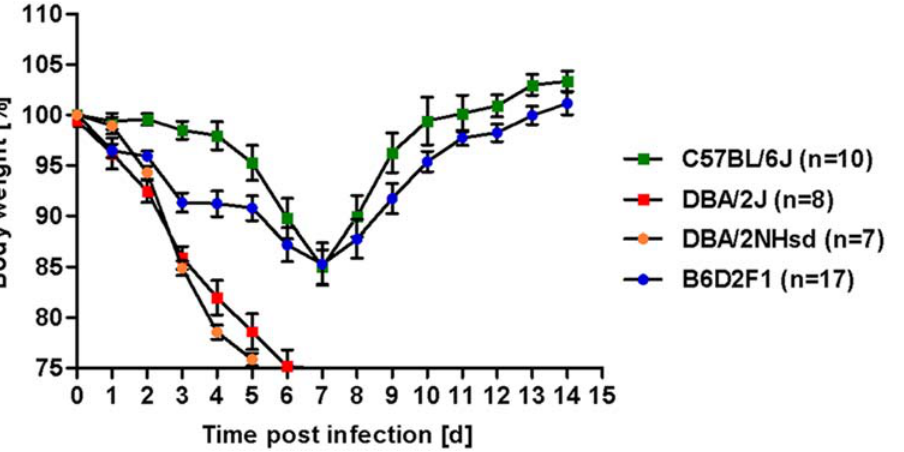
Figure 2. (C57BL/6J 6 DBA/2J) F1 mice display an intermediate phenotype after infection with Influenza A virus and DBA/2NHsd exhibit the same susceptibility as DBA/2J. C57BL/6J, DBA/2J, DBA/2NHsd and (C57BL/6J 6 DBA/2J) F1 (labeled B6D2F1 in the figure) mice were infected intra-nasally with 2 6 10 3 FFU PR8 virus. Weight loss and survival of infected mice was followed over a period of 14 days. Mortality also includes mice that were sacrificed because they had lost more than 25% of body weight. Mean percent of body weight change ( 6 SEM) are shown. For DBA/2J, C57BL/6J, and B6D2F1, data from two independent experiments were combined. p-values for significance were calculated for pair wise comparisons between all strains and for all days using non-parametric Mann-Whitney-U-test. The (C57BL/6J 6 DBA/2J) F1 group differed significantly in weight loss from days 2–4 when compared to the C57BL/6J group (p , 0.001 on days 2, 3; p , 0.01 on day 4) and from days 3–5 when compared to the DBA/2J and DBA/2NHsd groups (p , 0.01). On days 2–5, DBA/2J and DBA/2NHsd strains differed significantly in their weight loss from C57BL/6J (p , 0.001 for all cases, except p , 0.01 at day 5 for DBA/2NHsd vs. C57BL/6J). Weight loss was not significantly different between the sub-strains DBA/ 2J and DBA/2NHsd groups for all